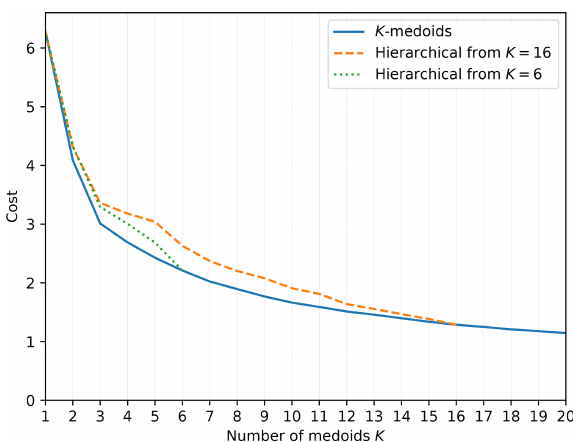
Figure 4. The behavior of the K -medoids loss L as a function of the number of medoids K . Blue solid line: the results of the K -medoids algorithm for each K . Orange dashed line: the result of starting with the K = 16 result and applying hierarchical clustering (as described in Sect. 4.2). Green dotted line: as above but starting with K =